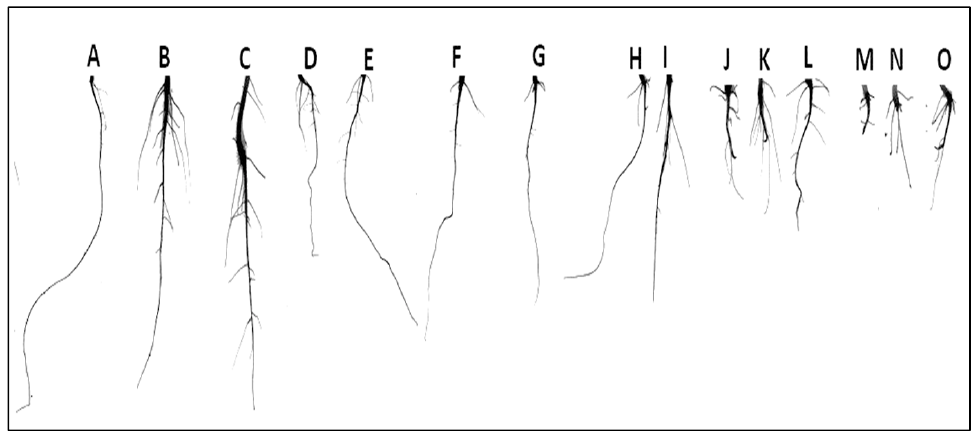
Figure 2. Root scanning images of 20-day-old B. alba seedling under different treatments, ( A ) control (0 mM Pb + 0 mg/L NPs), ( B ) ZnNPs, ( C ) FeNPs, ( D ) 4 mM Pb, ( E ) 4 mM Pb + ZnNPs, ( F ) 4 mM Pb + FeNPs, ( G ) 8 mM Pb, ( H ) 8 mM Pb + ZnNPs, ( I ) 8 mM Pb + FeNPs, ( J ) 15 mM Pb, ( K ) 15 mM Pb + ZnNPs, ( L ) 15 mM Pb + FeNPs, ( M ) 20 mM Pb, ( N ) 20 mM Pb + ZnNPs, ( O ) 20 mM Pb + FeNPs.